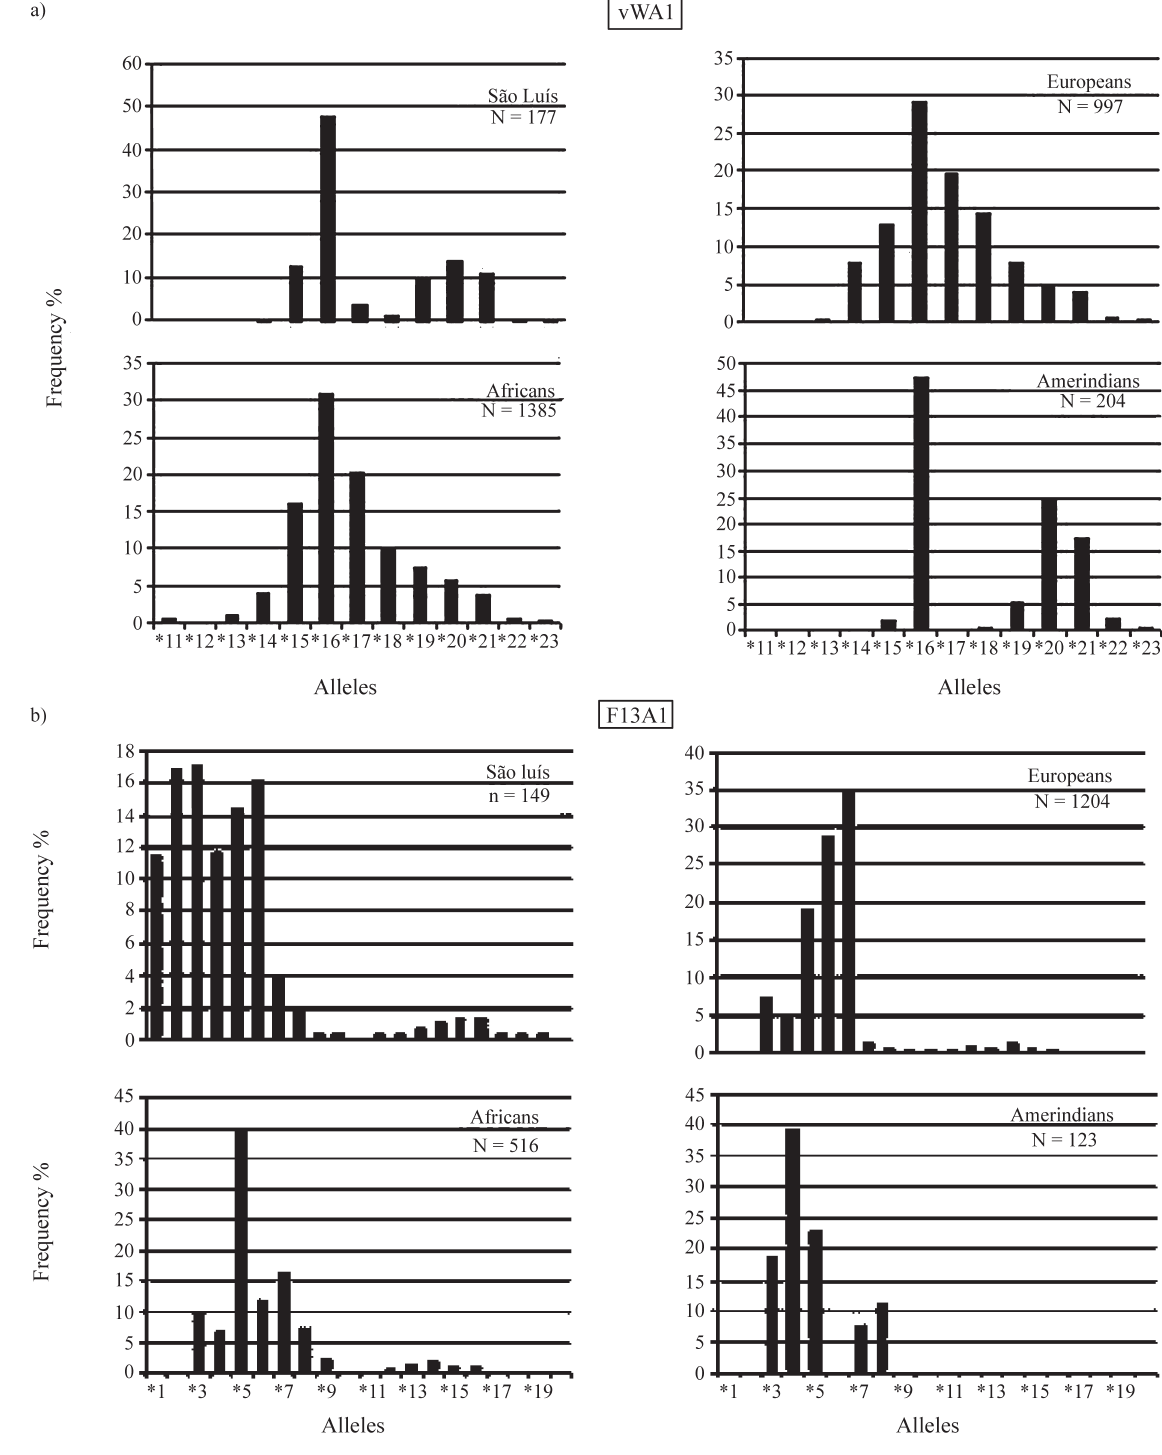
Figure 1 - Allele frequencies in the São Luís population and in the main ethnic groups that contributed to its